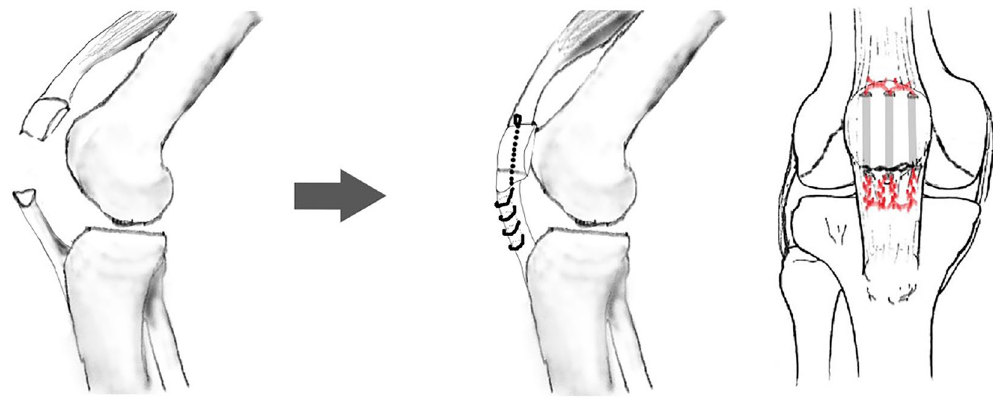
Figure 1. Without sacrificing distal bony fragments, two No.5 Ethibond sutures have been woven through the inferior patella pole and patellar tendon. The four ends of the suture were passed through the drilled tunnel and tied firmly over the intact edge of the patella upper